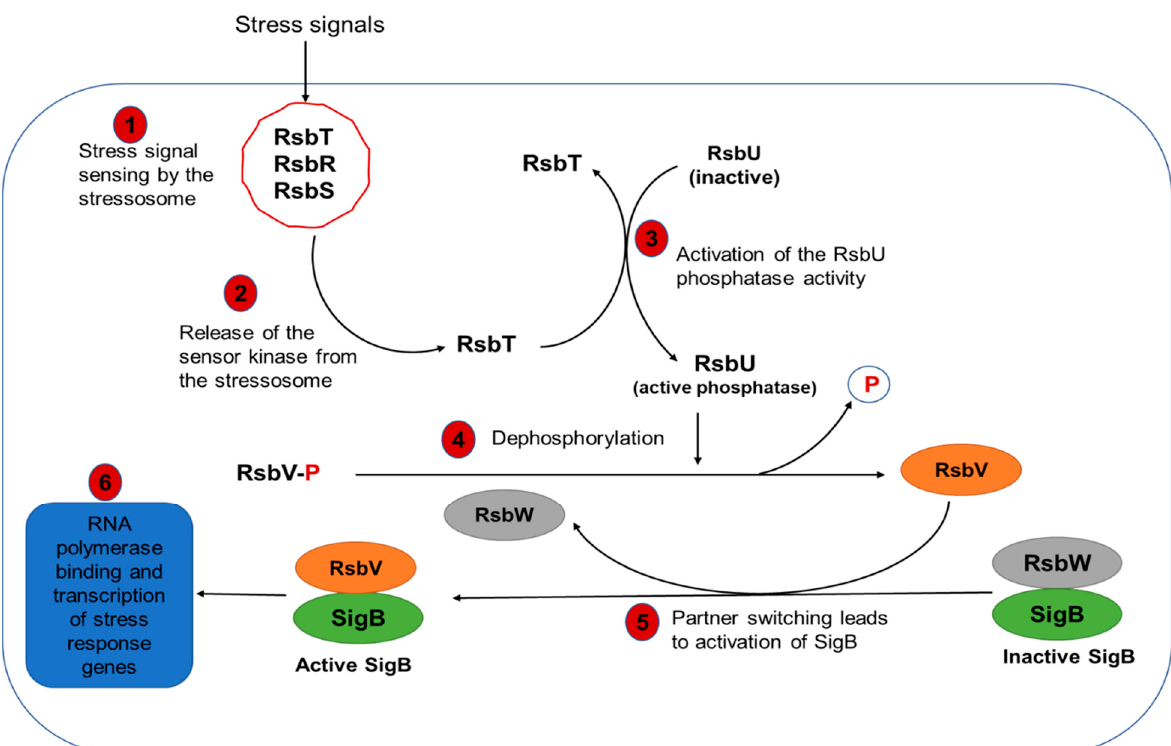
Figure 4. Mechanism of Rsb-mediated regulation of SigB expression and activity in L. monocytogenes